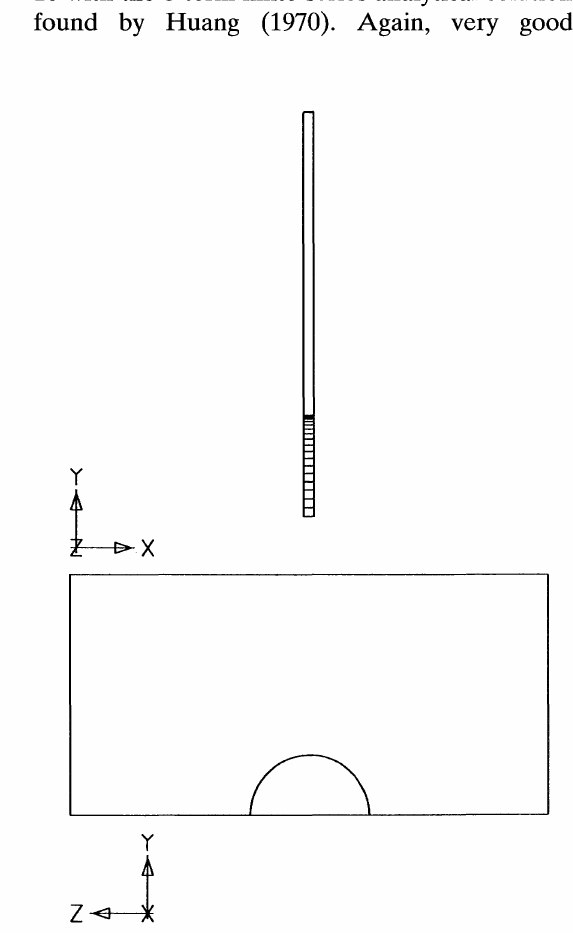
FIGURE 9 Size and position of infinite cylinder model relative to the Eulerian fluid volume for the infinite cylinder/plane step wave